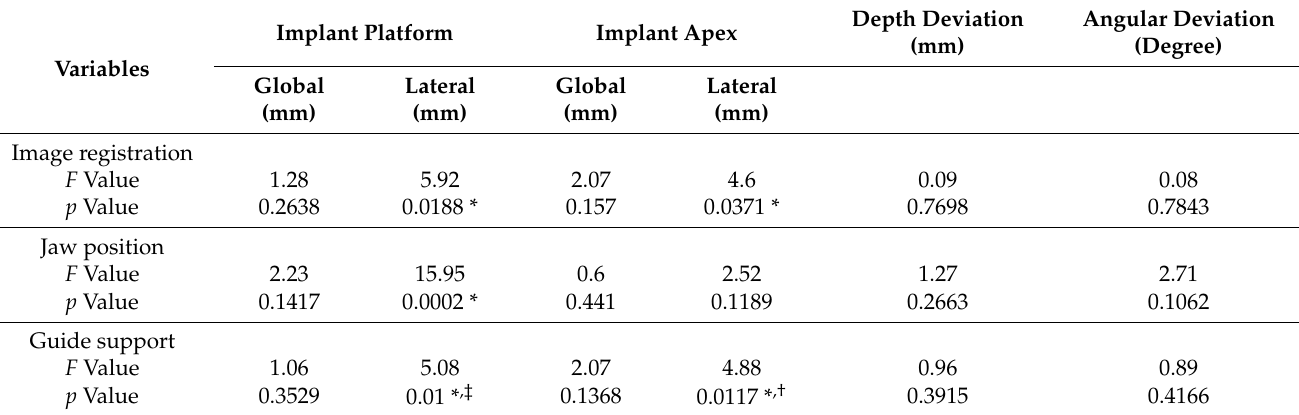
Table 4. Three-way ANOVA results of the significant independent variables in Table